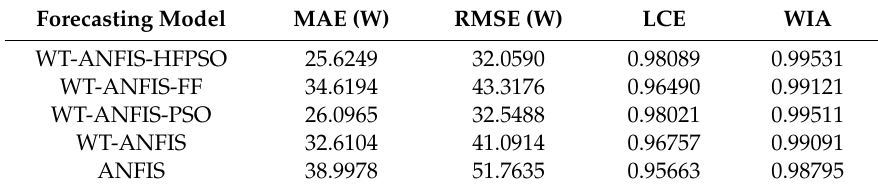
Table 6. Performance comparison of forecasting models on cloudy days.